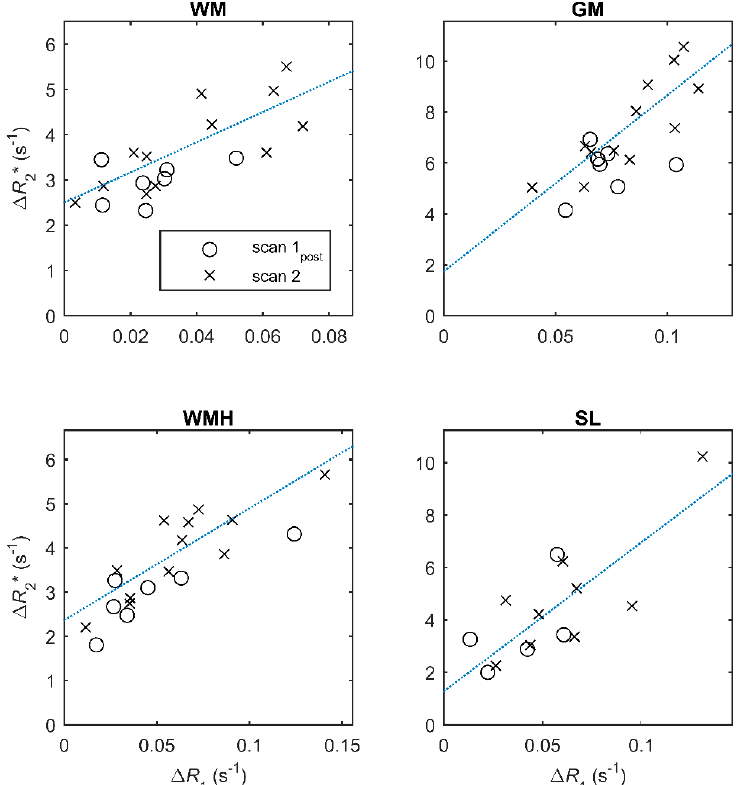
Figure 4. Change in R 2 * ( Δ R 2 *) versus change in R 1 ( Δ R 1 ) at scan 1 post (immediately post-USPIO; circles) and at scan 2 (24–30 h post-USPIO; crosses). Each data point represents the change in relaxation rate for a subject relative to the value measured at scan 1 (pre-USPIO). Dotted lines show the best fit to the data at scan 2; full linear regression results are given in Table 3.